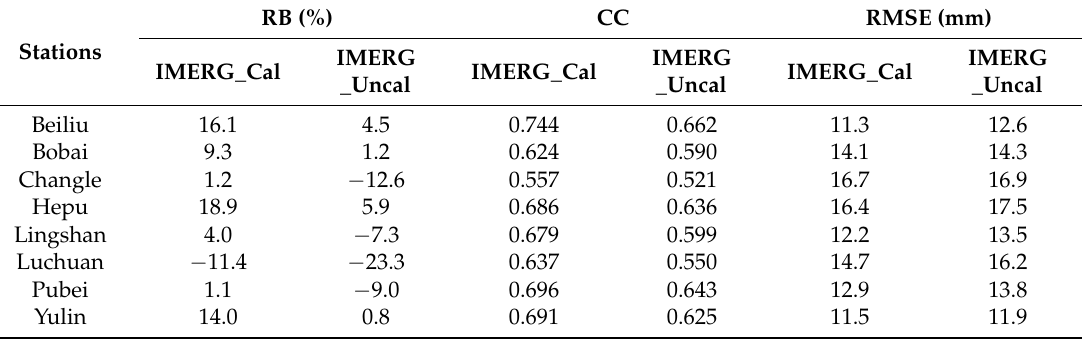
Table 2. Mean values of Relative Bias (RB) (%), Correlation Coefficients (CC), and Root Mean Square Error (RMSE) (mm), for the Integrated Multi-satellitE Retrievals for the Global Precipitation Measurement (GPM) mission (IMERG) and gauge precipitation, at the grid scale from April 2014 to December